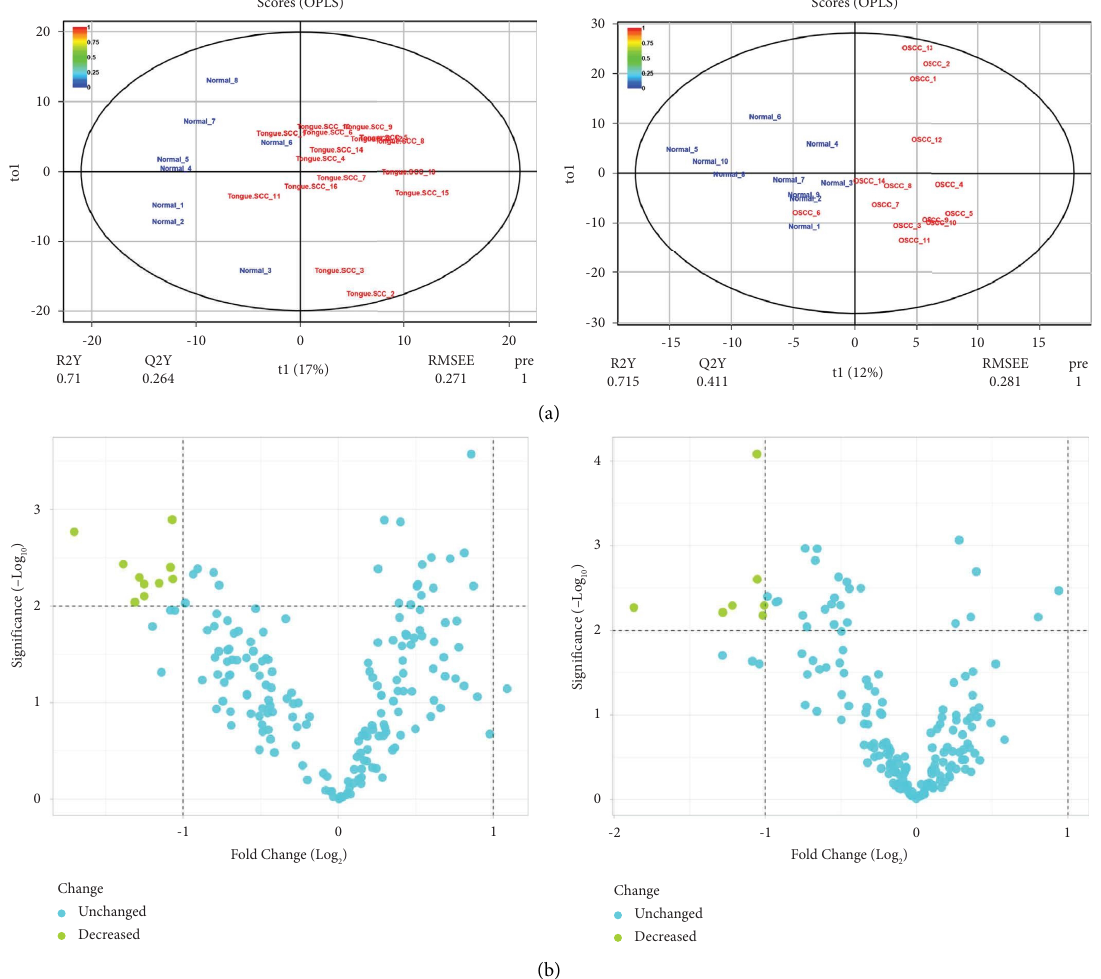
Figure 1: (a) Score plots in the predictive ( x -axis) and orthogonal ( y -axis) components of two datasets selected from GSE168227. (b) Volcano plots of miRNAs in OSCC compared to the normal oral tissues. Left and right images present results from OTSCC and BSCC tissues compared to their corresponding healthy samples, respectively. OTSCC, oral tongue squamous cell carcinoma; BSCC, buccal squamous cell carcinoma; OSCC, oral squamous cell carcinoma. Table 1: Diferentially expressed miRNAs in OTSCC and BSCC compared with the normal oral mucosa identifed by OPLS. A, DEMs in